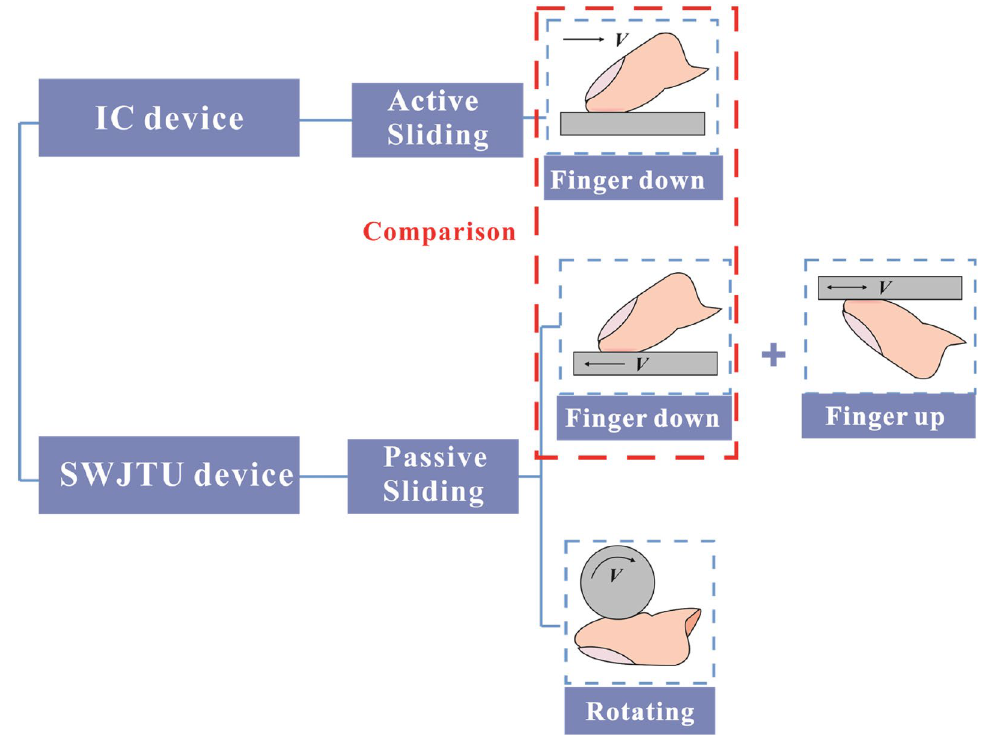
Figure 1 Schematic of different functions for IC and SWJTU device